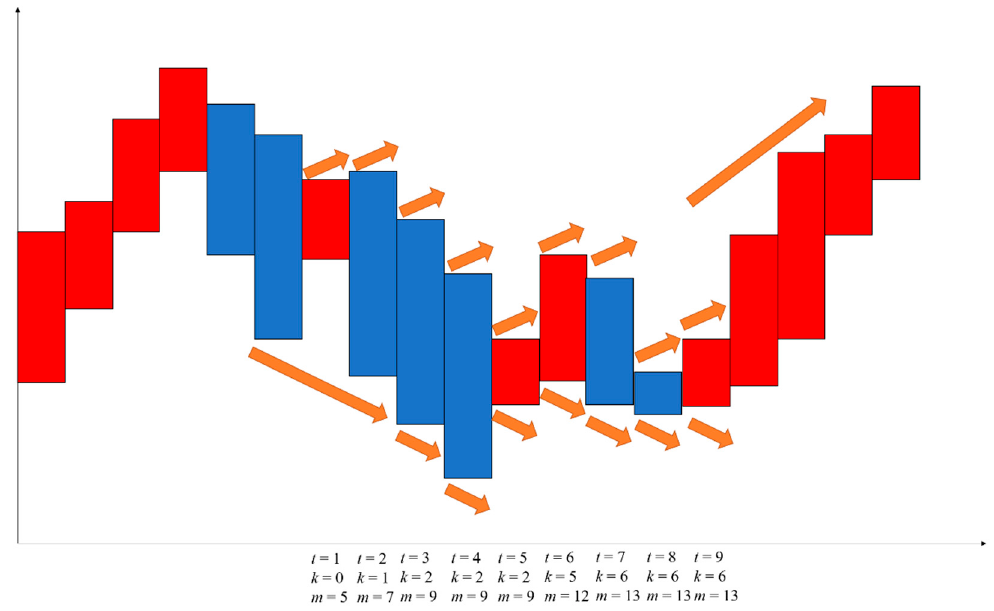
Figure 5. Practical example of the alert period (stock falling case).